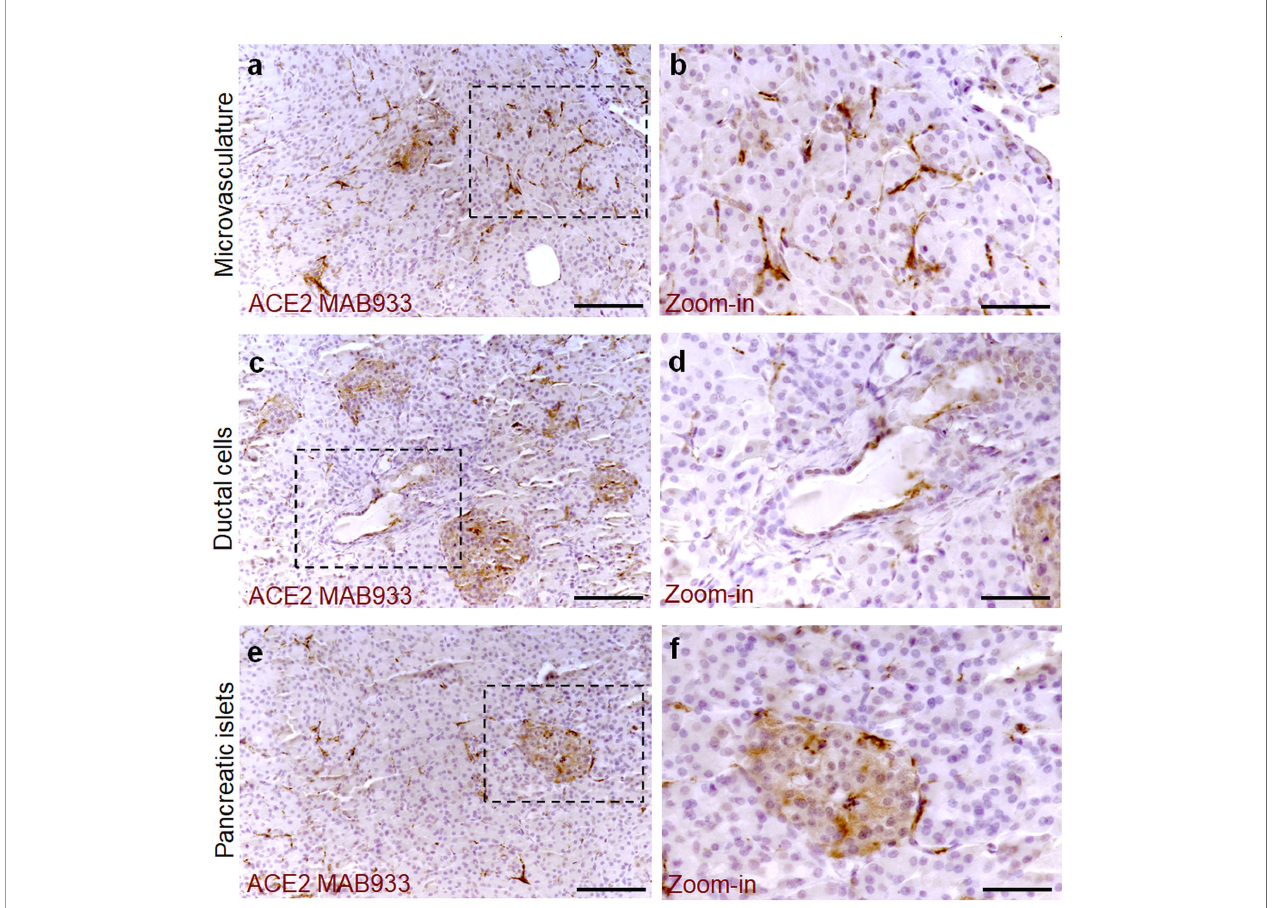
FIGURE 1 | ACE2 staining pattern in human pancreas. Immunohistochemistry for ACE2 in human pancreatic tissue sections (case #110118) using R&D MAB933 antibody. ACE2 is markedly expressed in microvasculature associated cells (A, B) in some rare ductal cells (C, D) and in a subset of endocrine cells within pancreatic islets (E, F) . Scale bars in (A, C, E) 150 µm. Scale bars in (B, D, F) 70 µm. Zoom-in images are reported in (B, D, F)